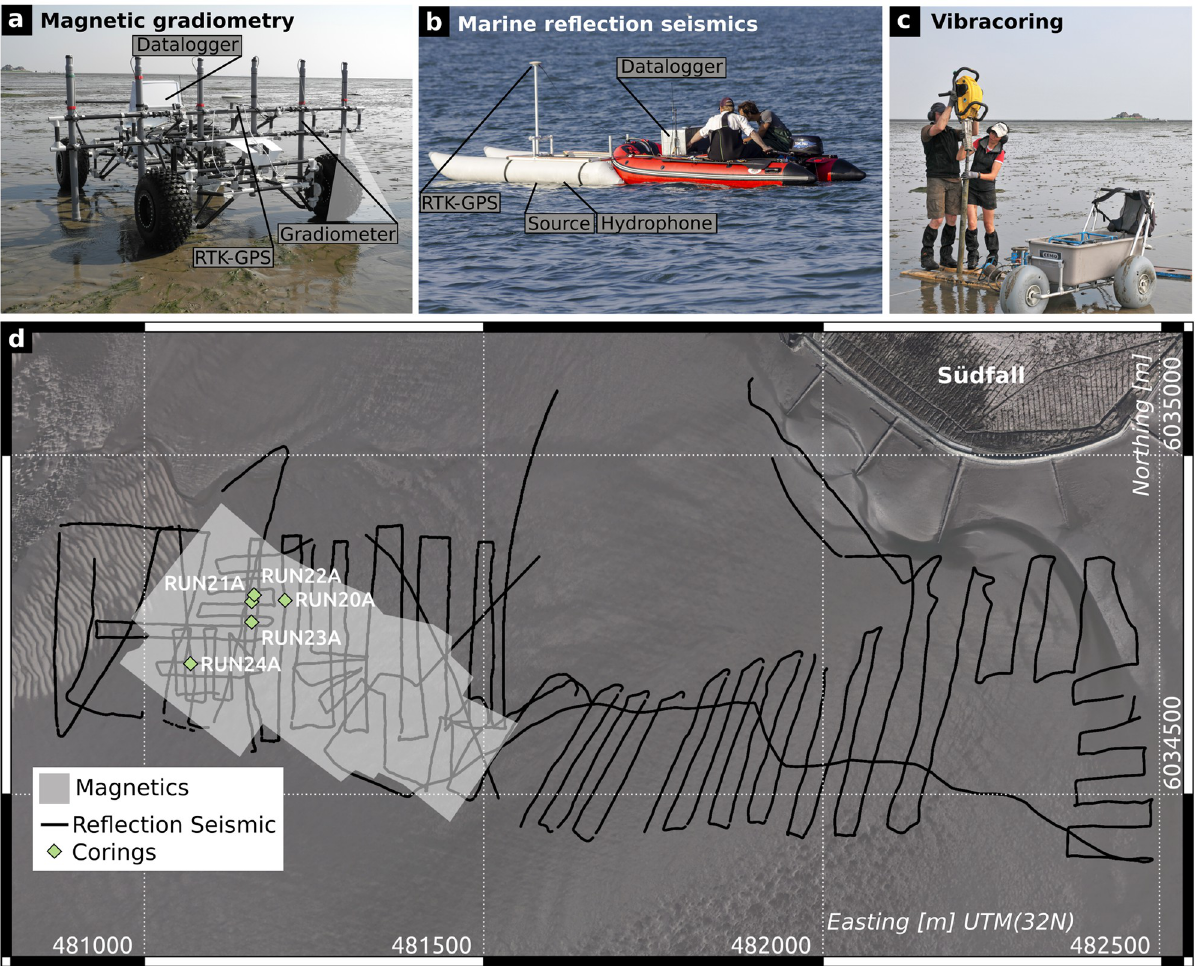
data sampling depends on the signal repetition rate (8 Hz) and travel speed of the boat, which led to an average spacing of about 0.16 m between data points along the boat track. Time data sampling frequency was set to 35.7 kHz with a record length of 57 ms. The positioning is per- formed by a Leica 1200 RTK-DGNSS (horizontal accuracy of up to 2 cm). Data